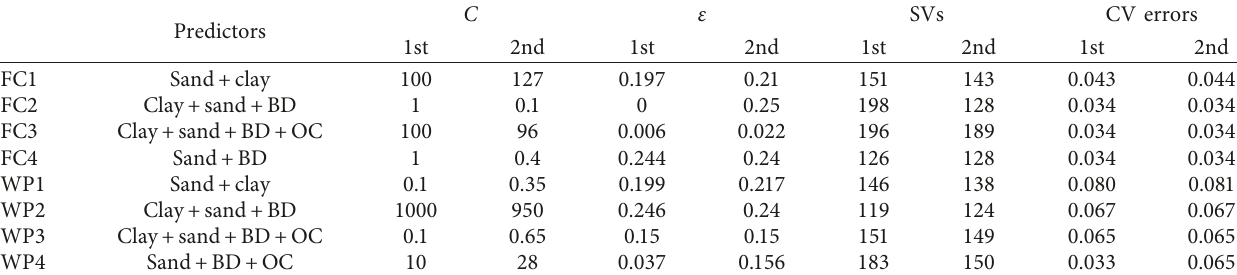
Table 4: Calibration results of optimal hyperparameters of SVR model types.